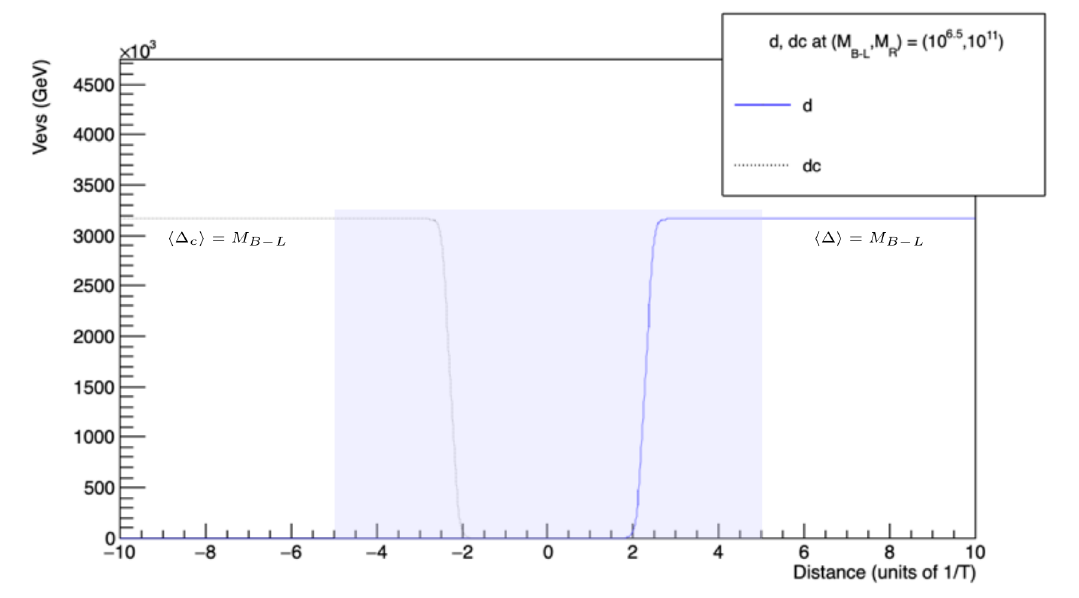
Figure 3 . Real and imaginary parts of the bidoublet Higgs fields, r 1 , r 0 of the distance x , in units of 1 /T , from the domain wall, plotted for T = M B − L = 10 6 . 5 GeV , M R = 10 11 GeV , and other parameters as in figure